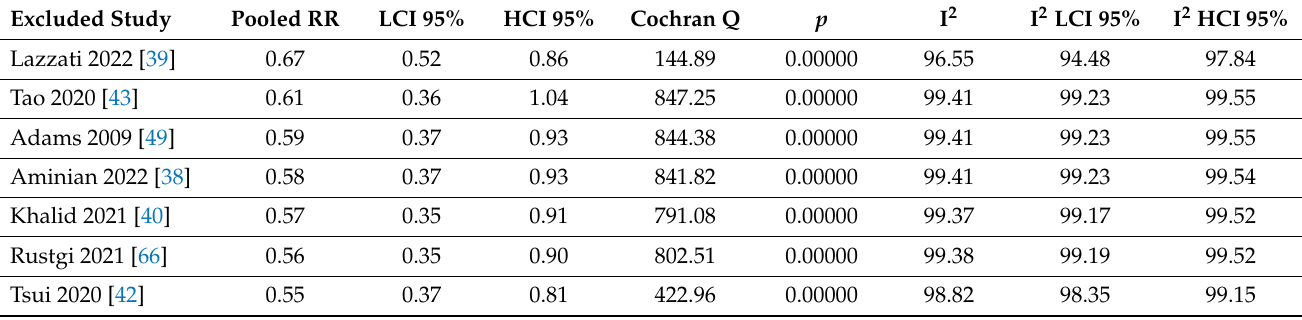
Figure A3. Cancer-related mortality RE funnel plot.